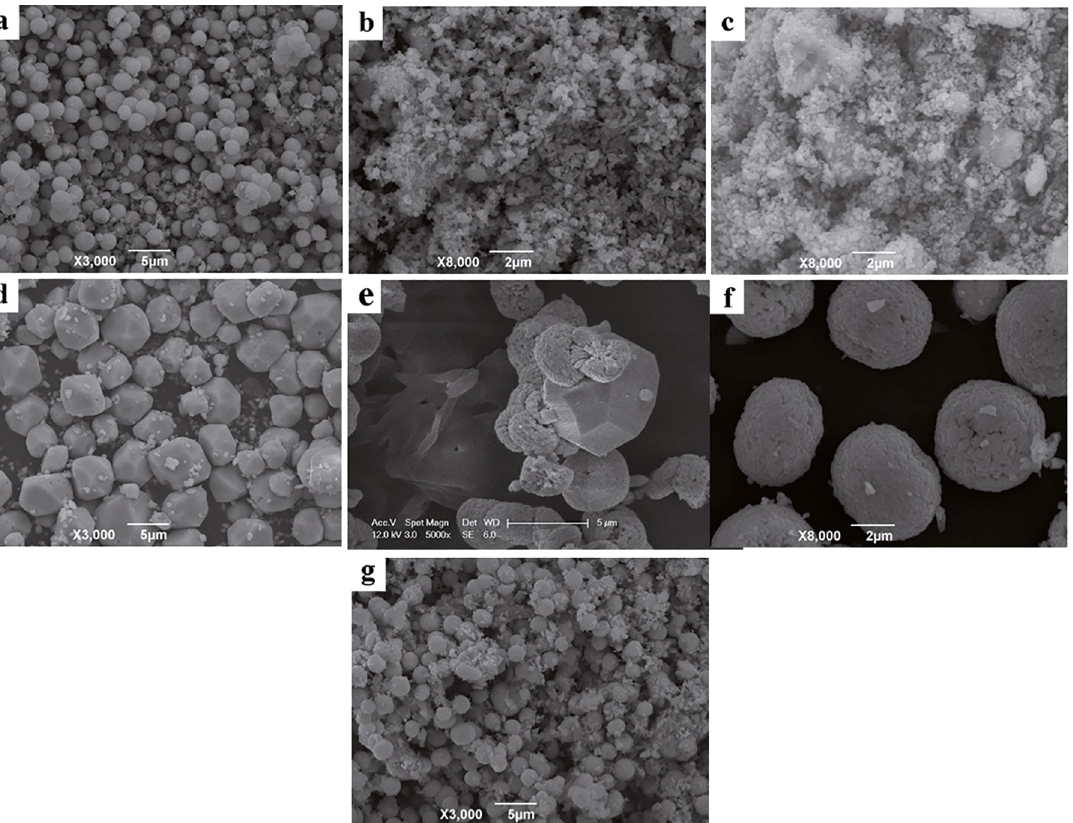
products obtained at different hydrothermal times at pH=5.00, 180 o C. (a) 1 h, (b) 4 h, (c) 8 h, (d) 16 Figure 8: SEM images of CdMoO 4 h, (e) 20 h, (f) 24 h, and (g) 48 h.